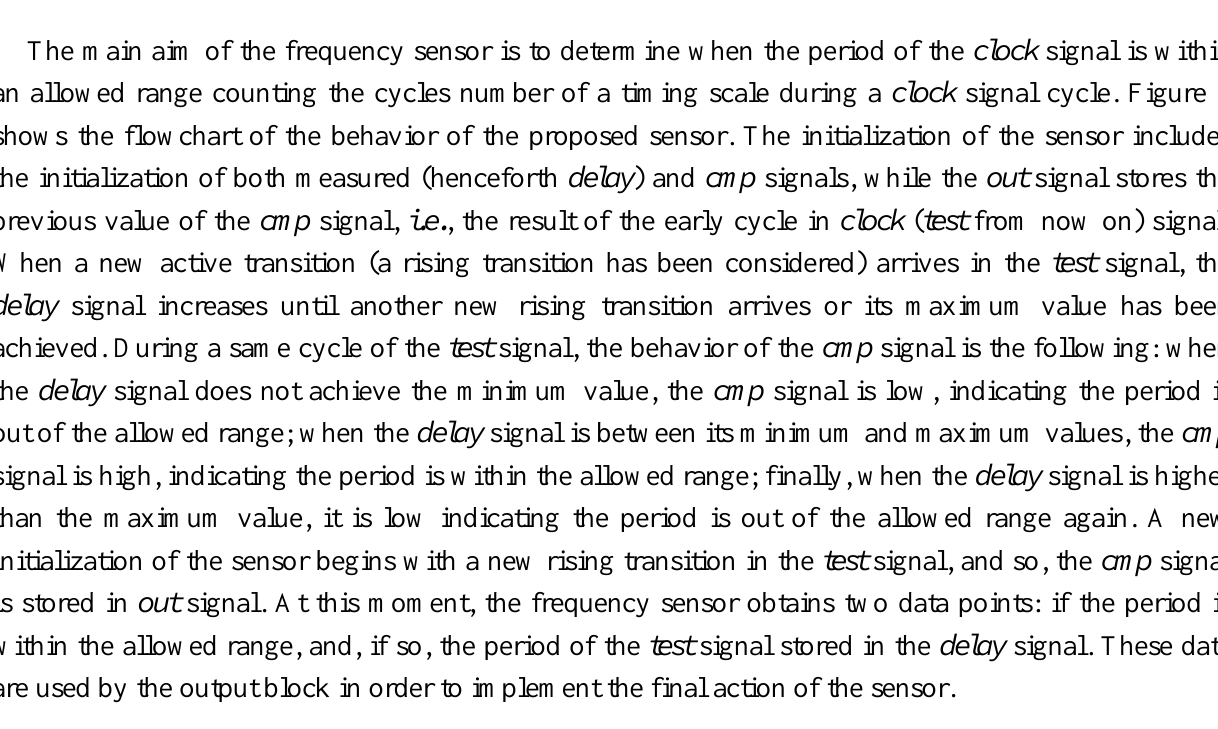
Figure 1. Behavior of the sensor